Question: Generate an informative caption for the figure above.
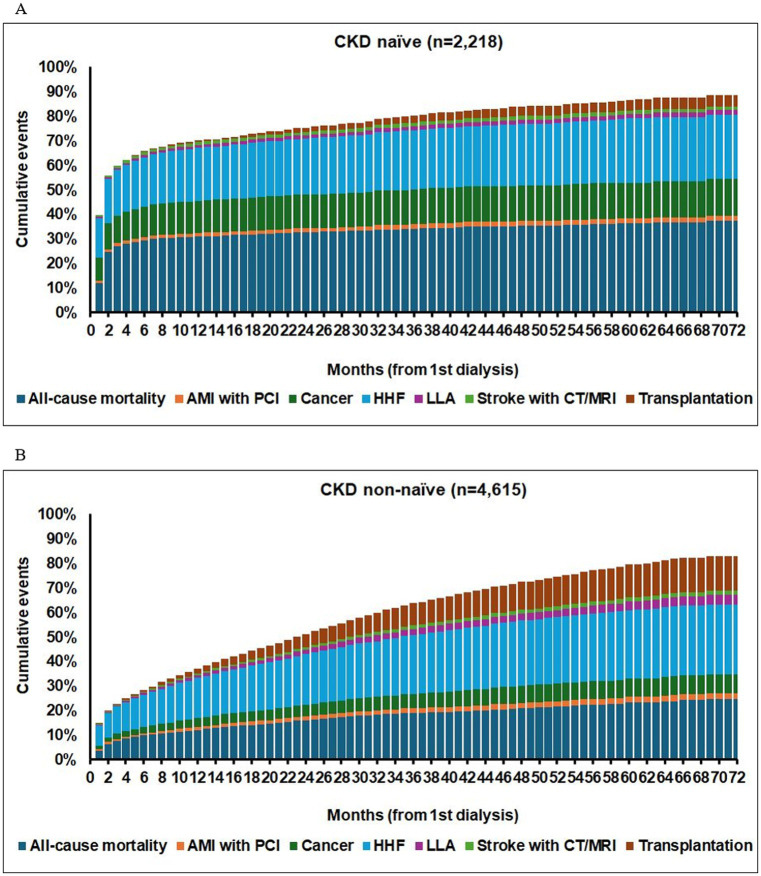
Answer: Integrated summary of the primary endpoints in the (A) CKD naive arm ( n = 2,218) and (B) CKD non-naive arm ( n = 4,615) during the 72-month follow-up after the first dialysis. Results are outputs of the cumulative event rates from the time-to-first event analyses. Total number of events were n = 3,031 in the CKD non-naive arm, and n = 1,815 in the CKD naive arm. The top 3 events were all-cause death, HHF (hospitalization for heart failure), and cancers in the CKD naive arm. The top 3 events were HHF, all-cause death, and kidney transplantation in the CKD non-naive arm. Data are unadjusted for the different propensity score subclassification hazards (no differences in hazards and statistics provided). AMI with PCI: acute myocardial infarction with percutaneous coronary intervention; LLA: lower limb amputation.